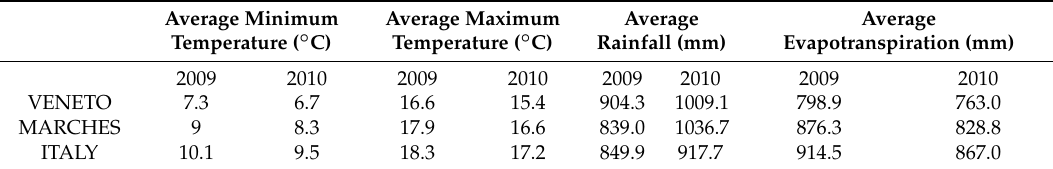
Table 1. Minimum and maximum average temperatures ( ◦ C), rainfall (mm), and evapotranspiration values (mm): average of 2009 and 2010 in Veneto, Marches, and Italy (data